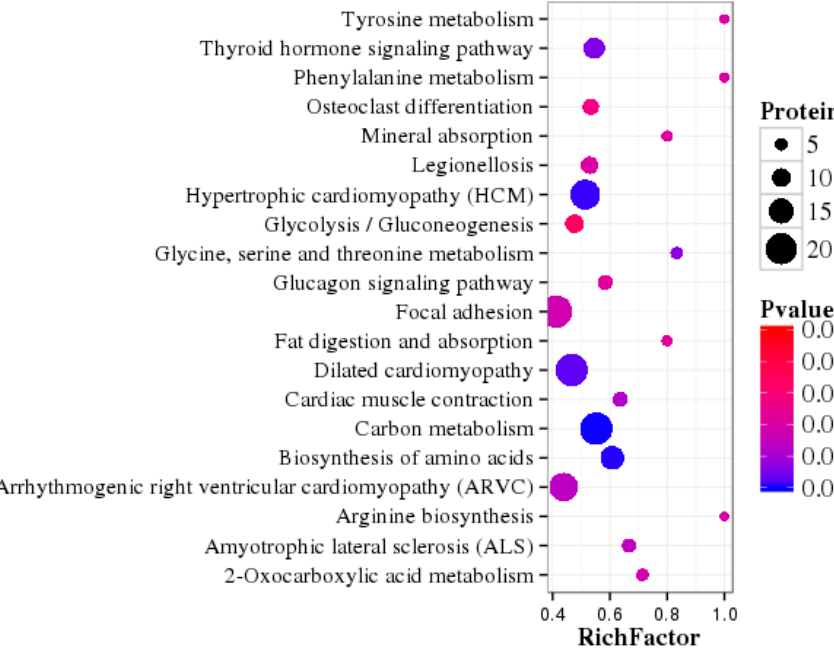
Figure 5. Top 20 pathway enrichment of differentially expressed proteins. Rich Factor is the ratio of the DEPs number annotated in this pathway term to all protein numbers annotated in this pathway term. A greater Rich Factor means greater intensiveness. A lower P value means greater intensiveness.